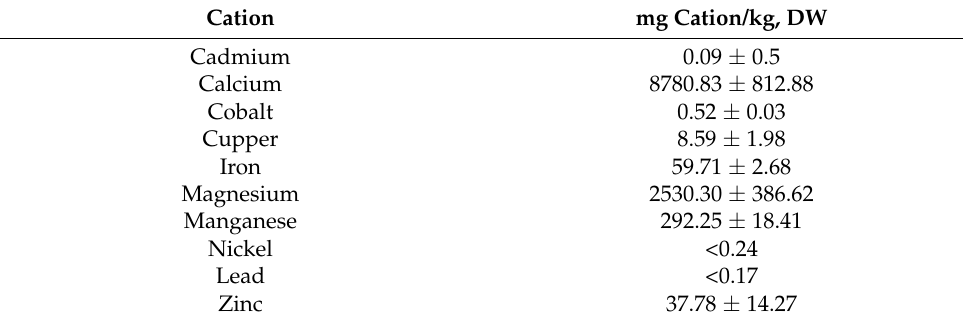
Table 6. Concentration of metals in dry leaves from B. macrantha